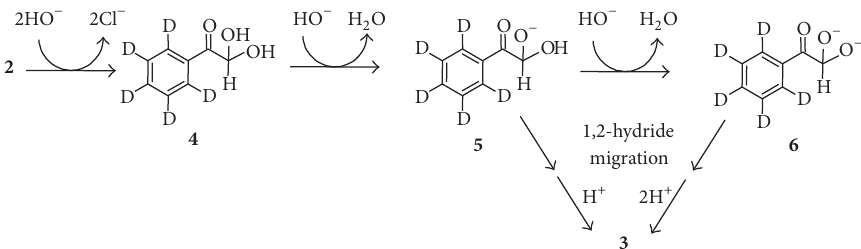
S 2: Intramolecular Cannizzaro disproportionation of phenylglyoxal-